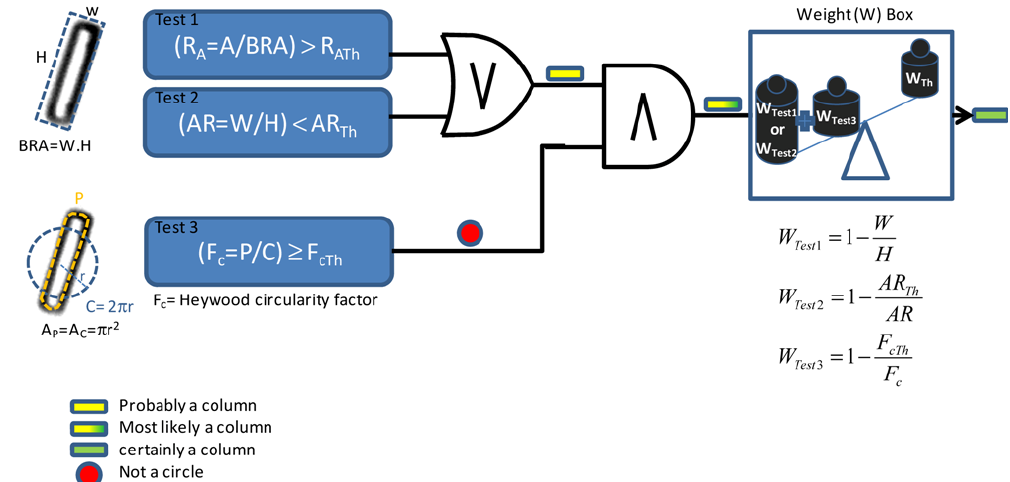
Fig. 7. Particle classification. A flowchart illustrates the algorithm used to sort out columnar particles from a set of particle images. Three tests contribute to the final decision with different weights; test 1: the ratio ( R A ) between the particle area ( A ) the bounding rectangle area (BRA), test 2: the aspect ratio (AR) and test 3: the Heywood circularity factor ( F c ). W: denotes the weight of the test. It is a measure of how far the tested criterion is satisfied. The Heywood circularity factor is the ratio between particle perimeter and the circumference of equal area circle. The subscript (th) denotes the threshold value of the corresponding parameter.